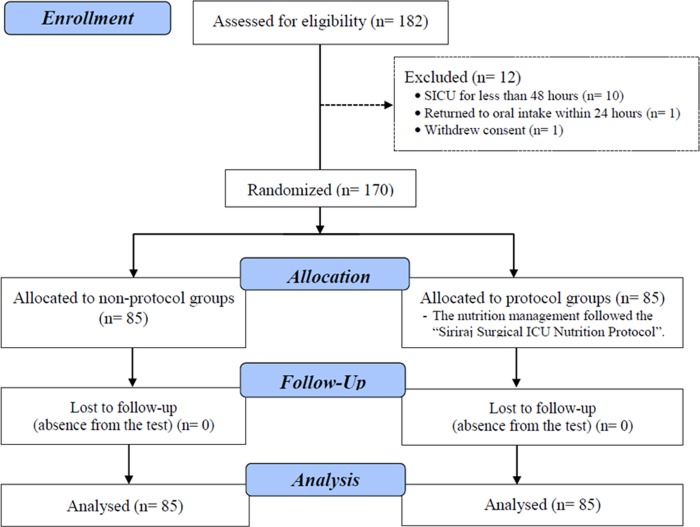
Consort flowchart.